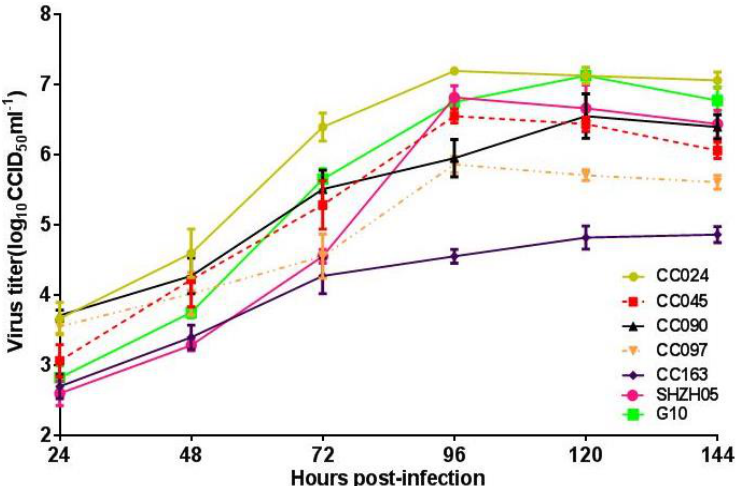
Figure 2. Growth kinetics of various CA16 virus strains in Vero cells. Cells were infected at the MOI of 0.01, and the titer of the CC024 strain (10 7.2 CCID 50 /mL) was the highest among the seven viruses at 96 h post-infection